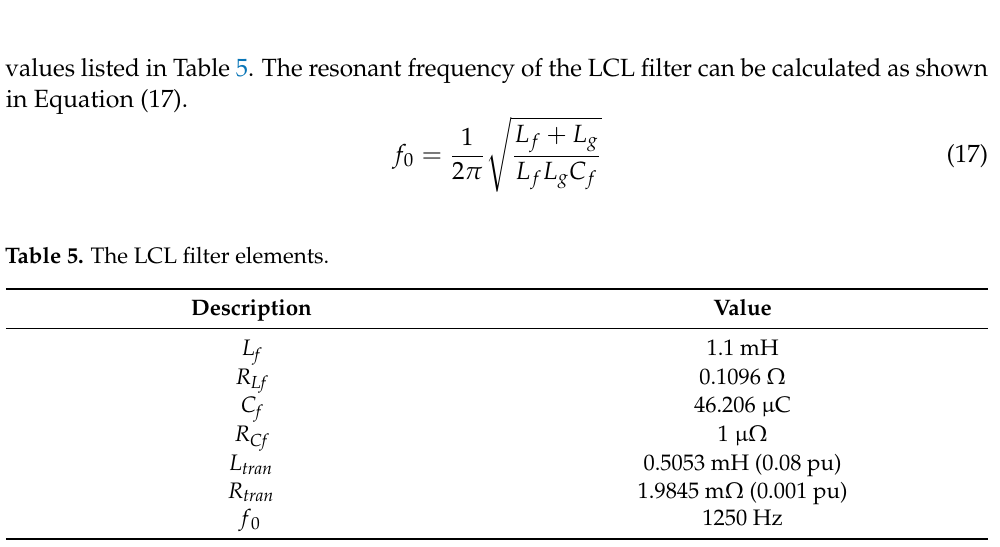
Figure 14. The LC low-pass filter schematics: ( a ) without transformer; ( b ) with transformer acting as the load-side inductor and forming the resulting LCL-type filter.